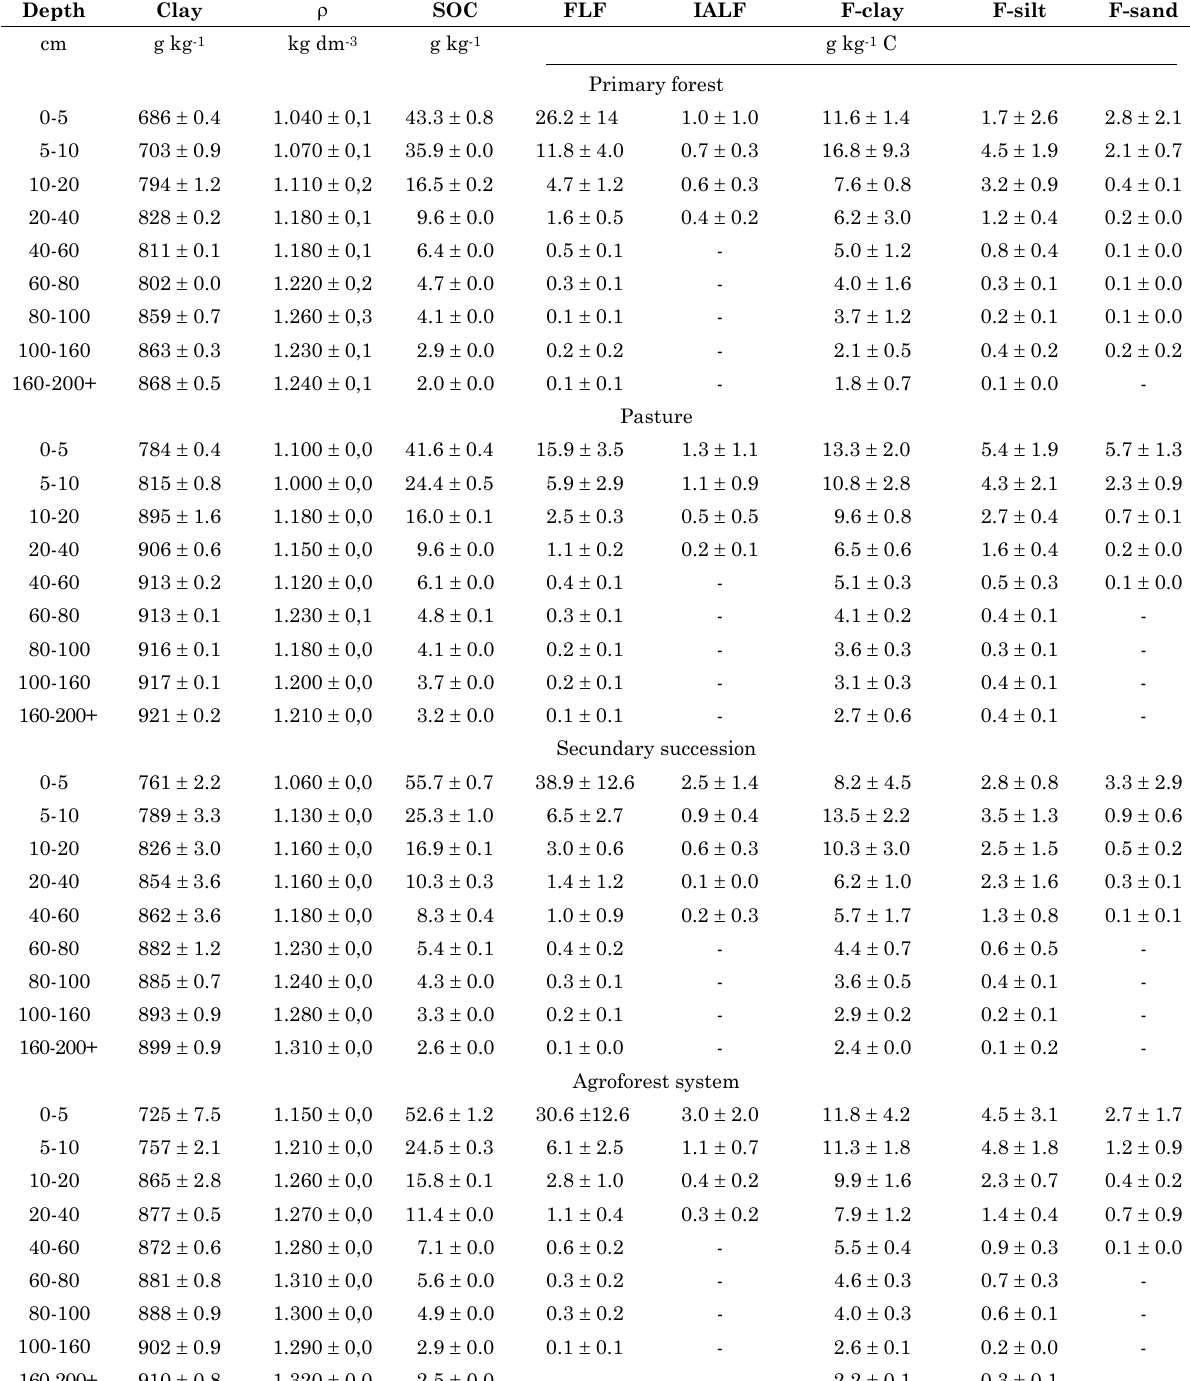
Table 2. Soil physical characteristics, soil organic carbon (SOC), and carbon contained in the soil fractions at different depths in primary forest, pasture, secondary succession, and agroforestry system